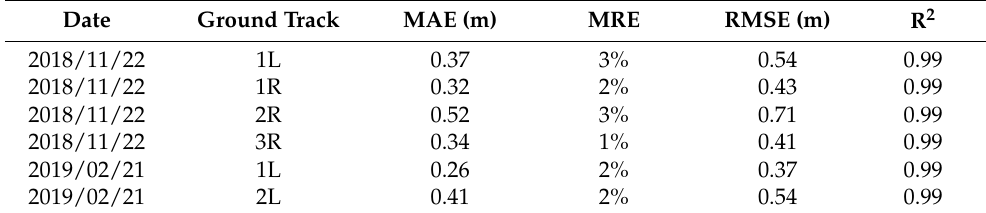
Table 2. Validation of ICESat-2 bathymetry results in St. Thomas